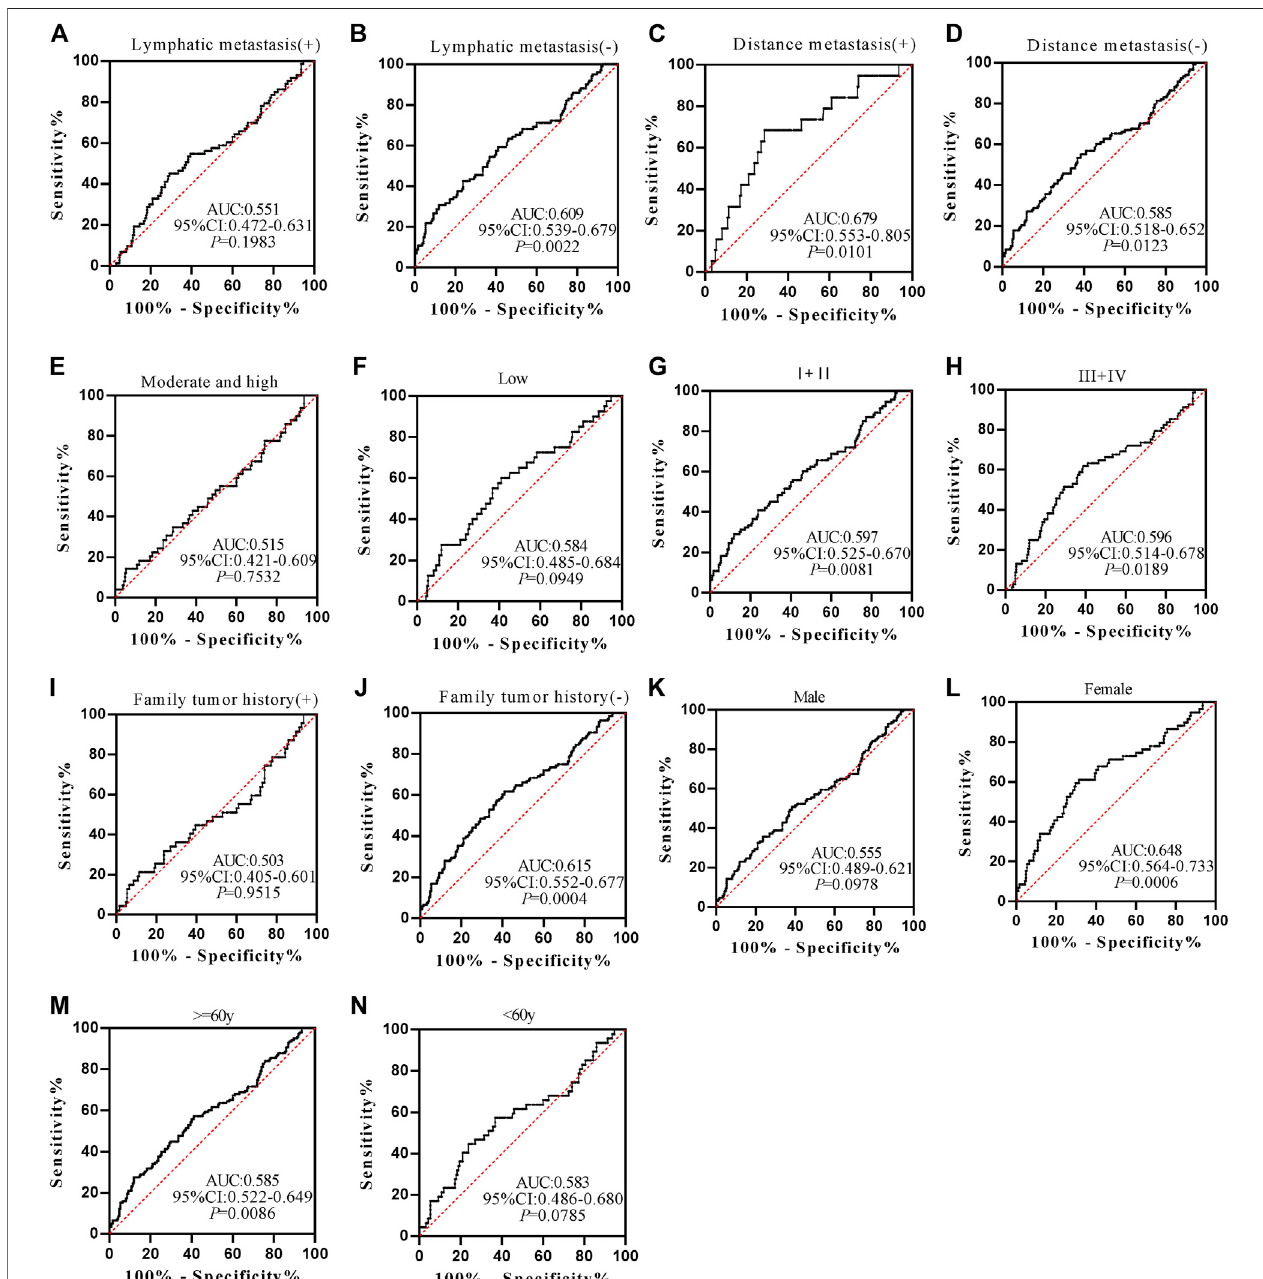
FIGURE 6 | The value of anti-TIMP1 autoantibody in diagnosing ESCC patients of different clinical subgroups.